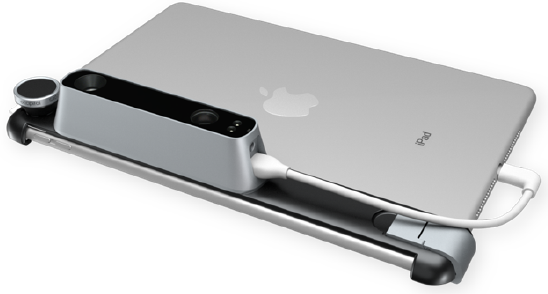
Figure 3. The Structure Sensor mounted on an